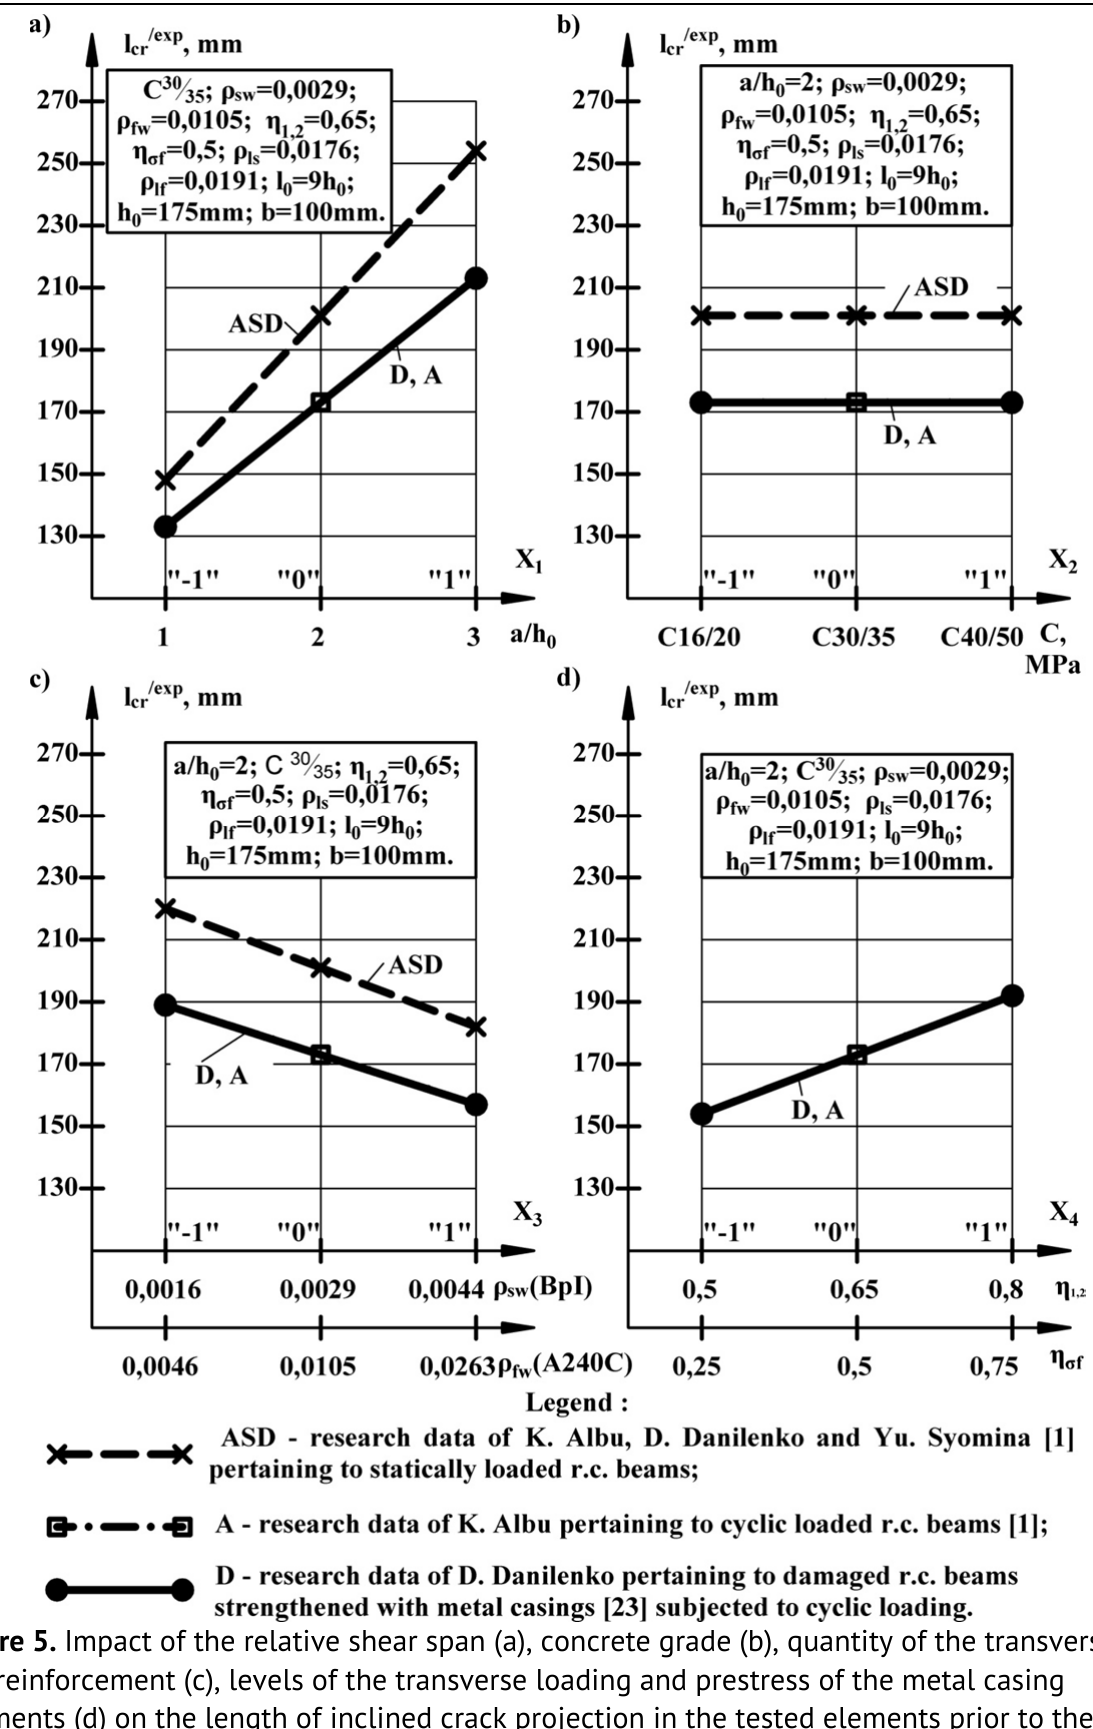
Figure 5. Impact of the relative shear span ( а ), concrete grade (b), quantity of the transverse reinforcement (c), levels of the transverse loading and prestress of the metal casing elements (d) on the length of inclined crack projection in the tested elements prior to their collapse of normal crack width in the tested beams prior to their